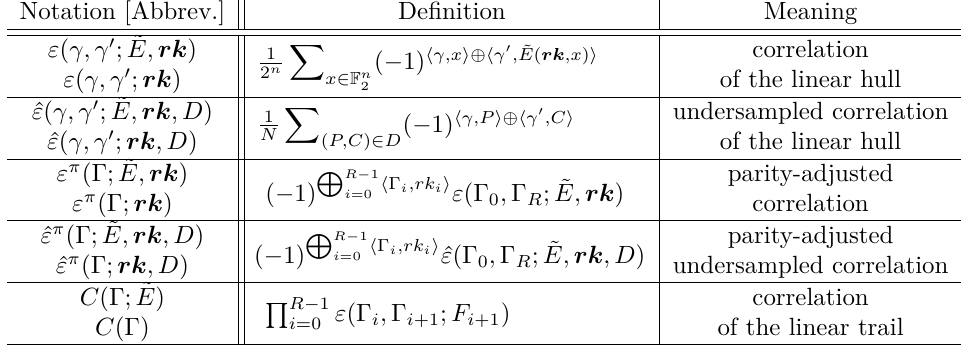
Table 2: Notations for